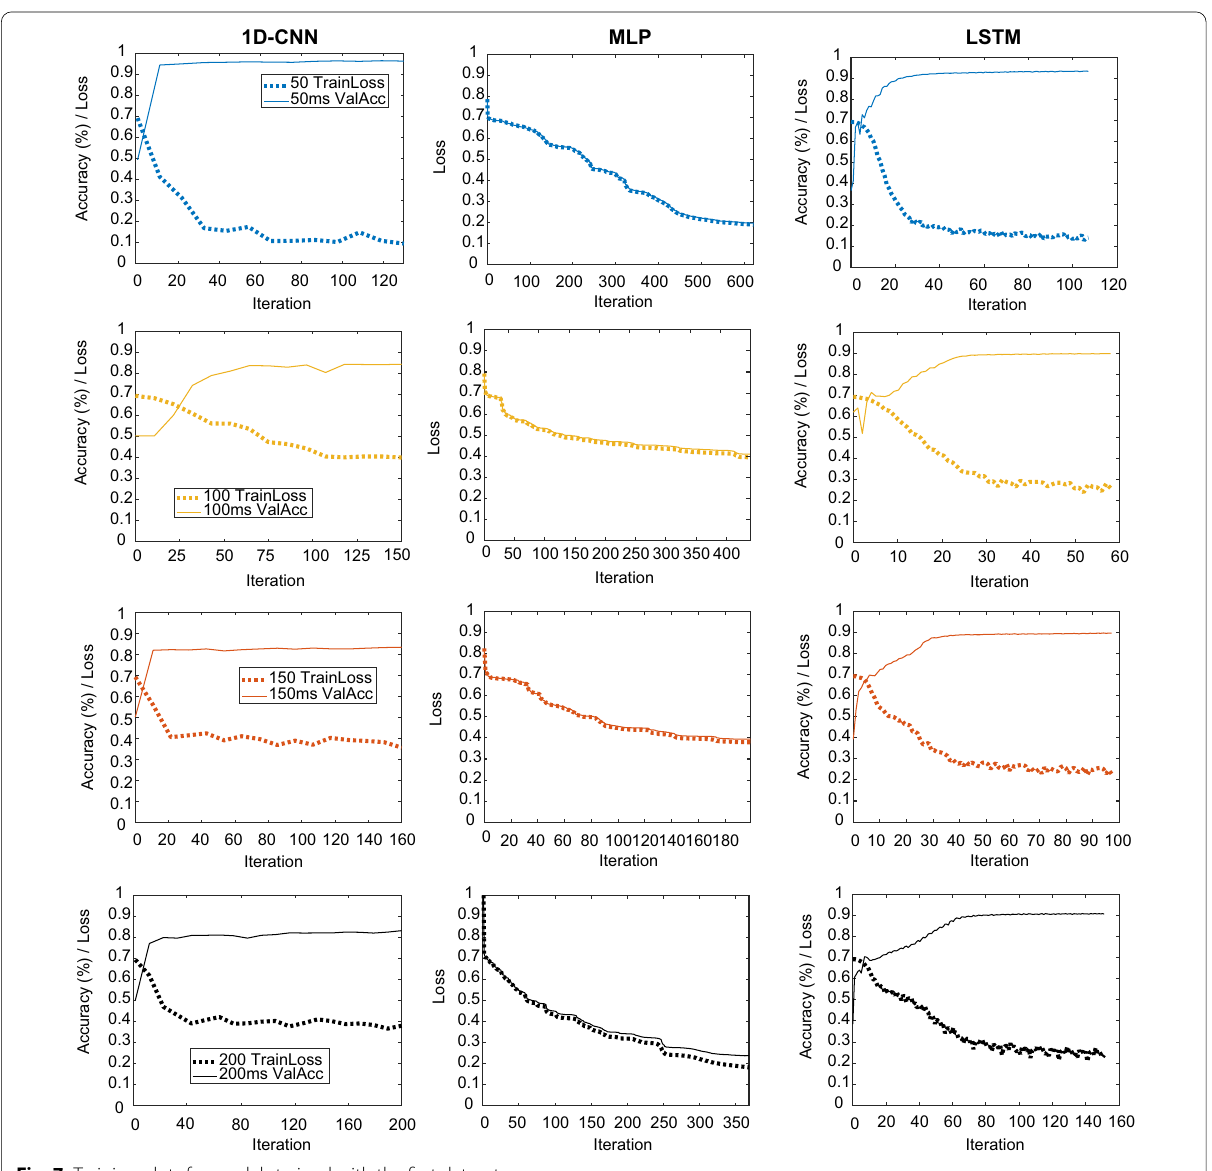
Fig. 7 Training plots for models trained with the first